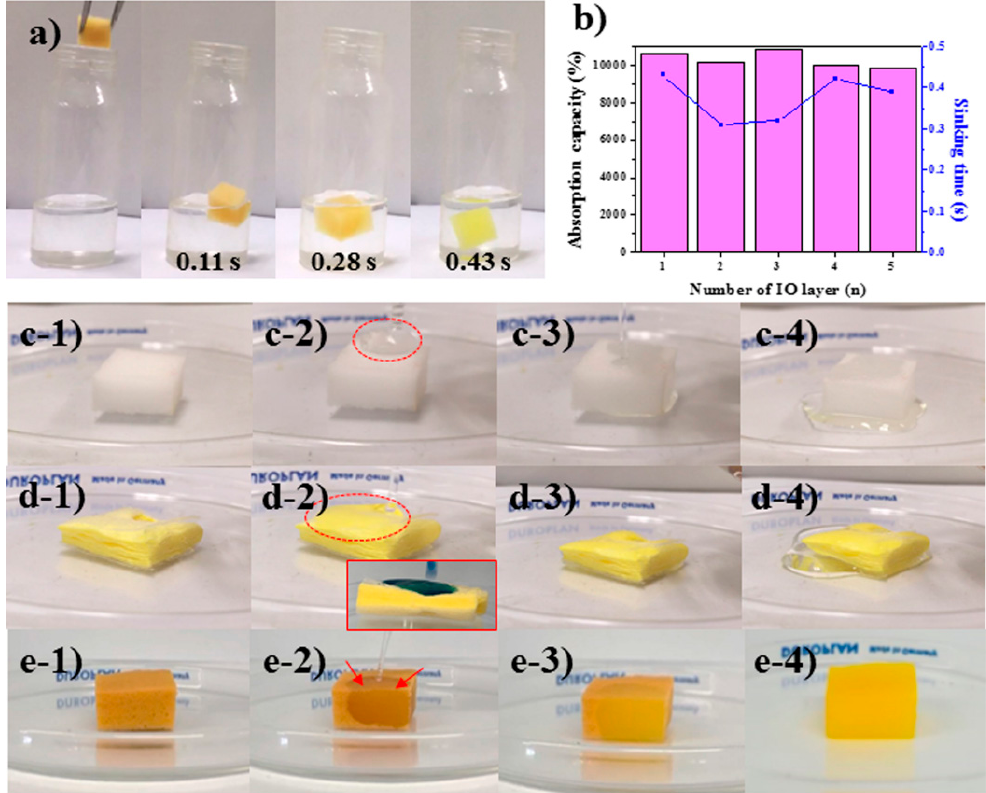
Figure 5. ( a ) Drop tests of MFS / IO(1) with a strong acid solution (15% HCl). ( b ) Absorption capacity and sinking time of MFS / IO(1–5) for a strong acid solution. ( c – e ) Solution drop tests. Drop test of a strong acid solution on ( c1 – c4 ) pristine MFS, ( d1 – d4 ) the pad, and ( e1 – e4 ) MFS / IO(3). (Inset of d2) Acidic water colored blue with methylene blue dye was used for visualization of the water stream.